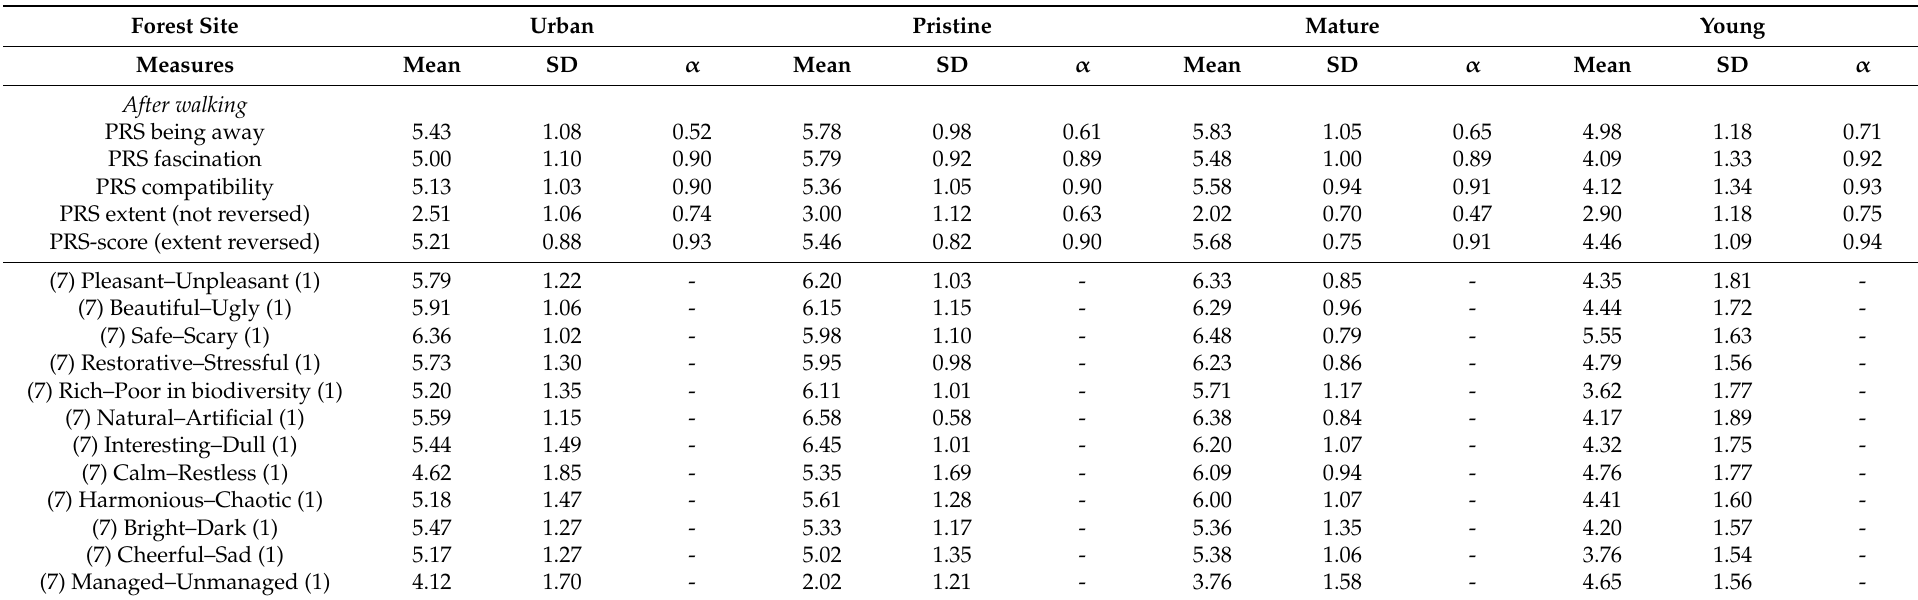
Table 2. Scale statistics of the four components in PRS, PRS-score and semantic differentials (adjective-pairs). Forest Site Urban Pristine Mature Young Measures Mean SD α Mean SD α Mean SD α Mean SD